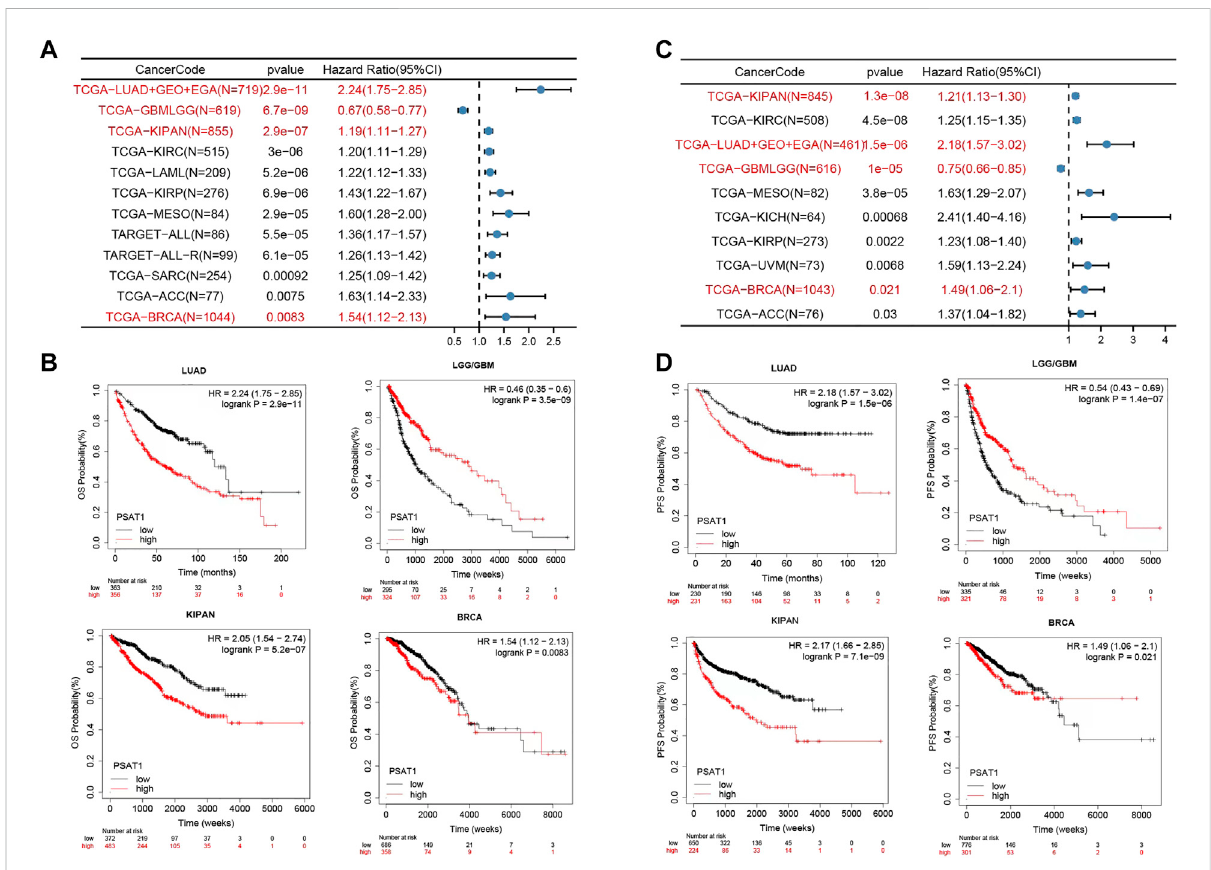
FIGURE 5 The relationship between PSAT1 gene expression and survival prognosis of cancers. (A) Forest map showing the relationship between the expression of PSAT1 and OS rate in Pan cancer (B) Kaplan-Meier curve showing the effect of PSAT1 gene expression on the OS in LUAD, LGG/GBM, KIPAN and BRCA (C) Forest map showing the relationship between the expression of PSAT1 and PFS rate in Pan cancer (D) Kaplan-Meier curve showing the effect of PSAT1 gene expression on the PFS in LUAD, LGG/GBM, KIPAN and